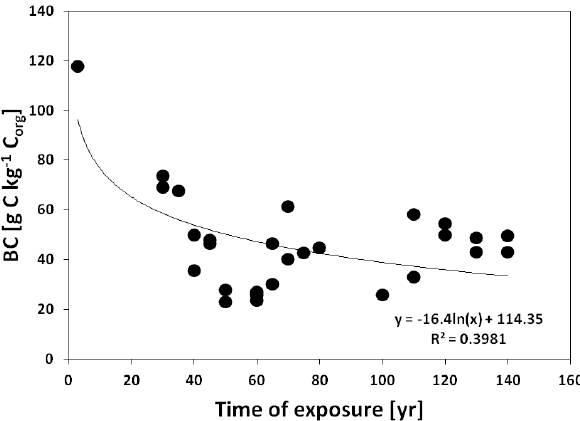
Fig. 5. Van Krevelen diagram showing the H/C and O/C atomic ratios of soils (mean values ± standard deviation of age classes). Grey shaded areas indicate areas of organic compounds after Kim et al. (2003) and Hammes et al.